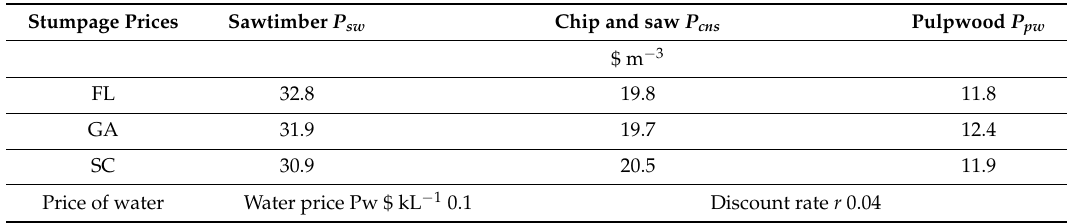
Table 2. Economic parameters for loblolly